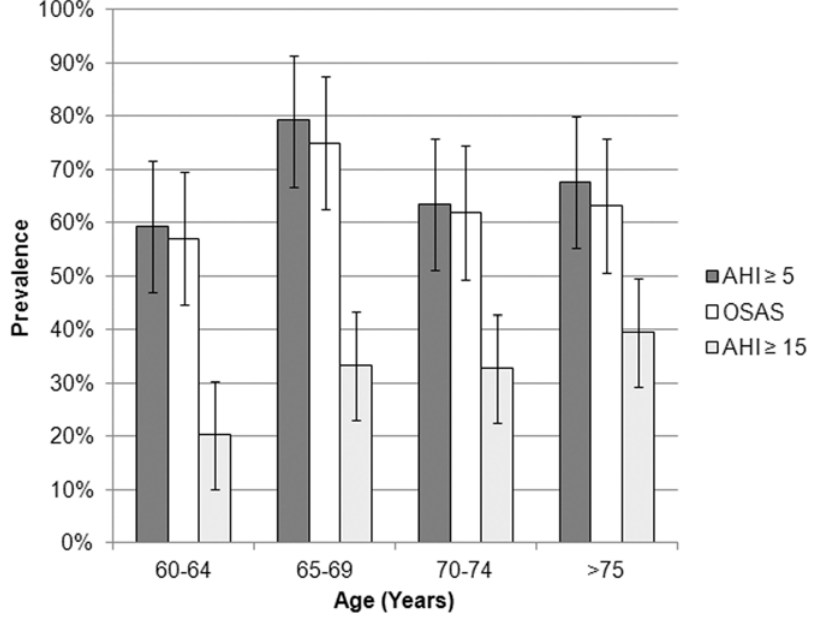
Fig 2. OSAS prevalence estimates with 95% confidence intervals are illustrated based upon AHI cutoffs of 5 and 15, and diagnosis of OSAS according to age quartile.